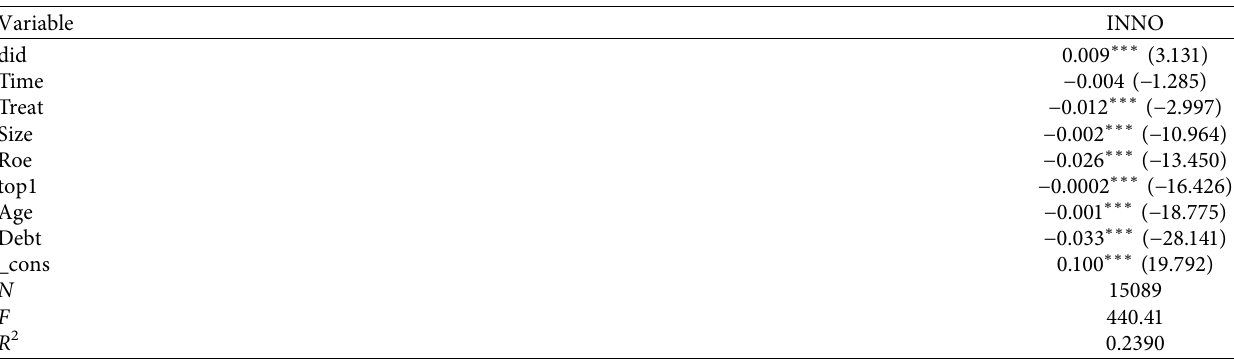
Table 10: The results of PSM-DID test.